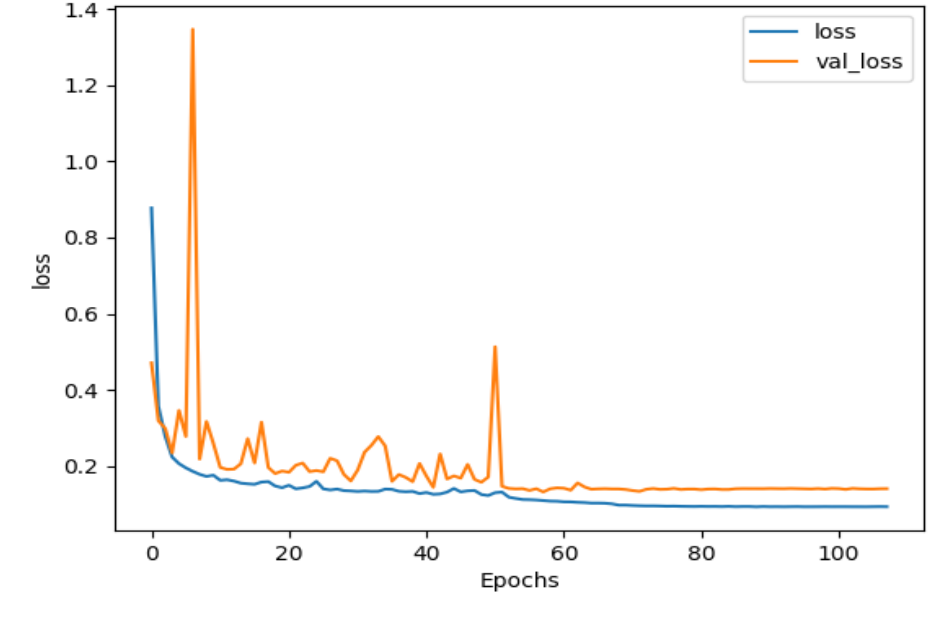
Figure 9. Loss curve for the DSB dataset.